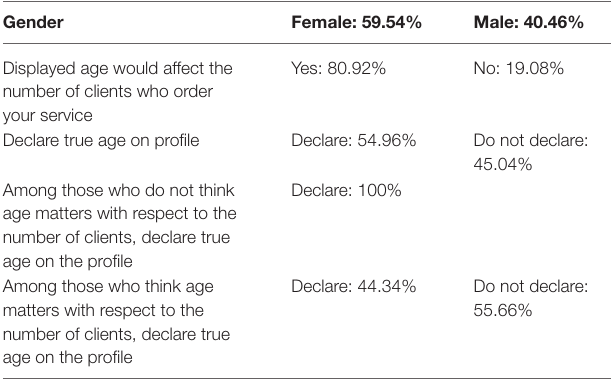
TABLE 1 | Distribution of answers in the 131 responses submitted by people over the age of